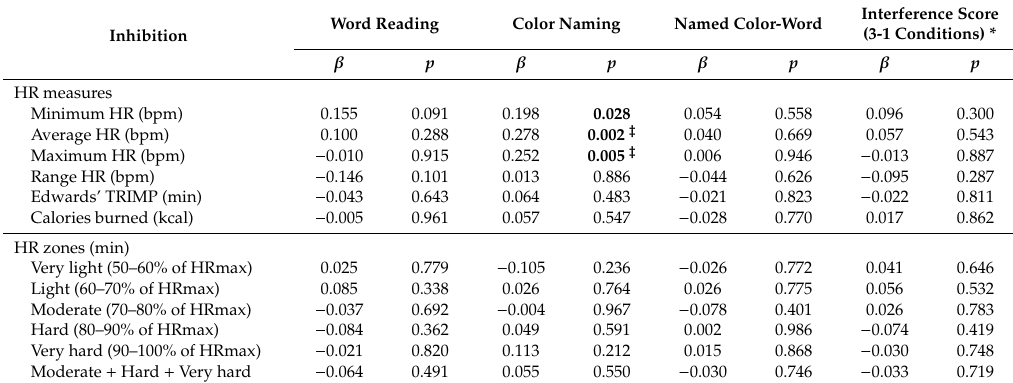
Table 5. Associations of HR measures with inhibition subdomains ( n =